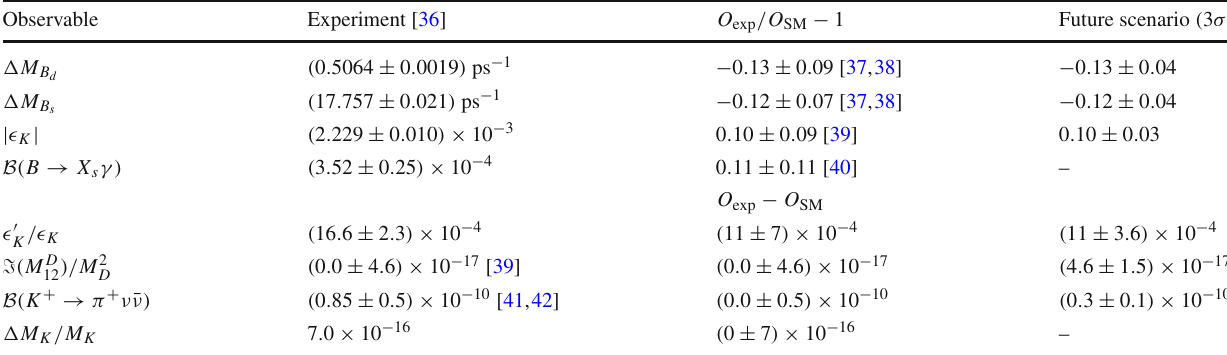
Table 1 Experimental values and SM predictions for the observables used in the numerical analysis (see main text) Observable Experiment [36] O exp / O SM − 1 Future scenario ( 3